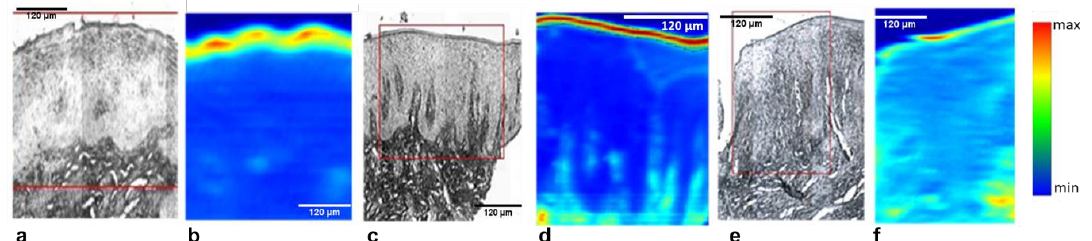
Figure 2. Representative white light ( a , c , e ) and corresponding FTIR chemical maps ( b , d , f ) using glycoprotein band (1385 cm −1 ). Areas of spectral extraction in the superficial layer of control ( a , b ), non-irradiated ( c , d ), and irradiated ( e , f ) samples are marked.